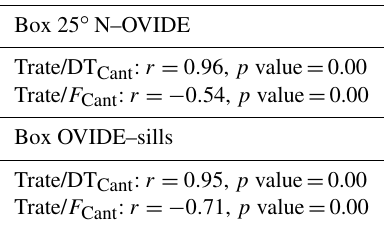
Table 4. Correlation coefficient ( r ) and p value between the time rate of change (Trate), the divergence of Cant transport (DT Cant ) and air–sea Cant flux ( F Cant ) for the boxes, 25 ◦ N–OVIDE and OVIDE–sills, over the period 2003–2011. DT Cant = incoming – outgoing Cant fluxes across the boundaries of